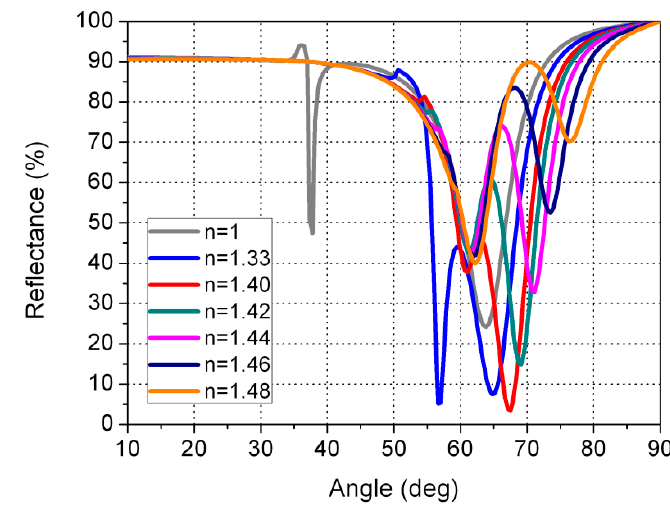
Figure 8. Reflectance curves as a function of the angle of incidence of the light in the prism for a gold layer of 68 nm. The thickness of the dielectric layer of the MgF 2 is 190 nm.